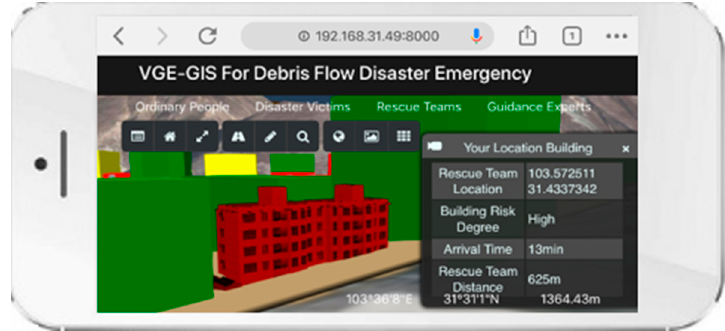
Figure 8. Virtual debris flow disaster environment for disaster victims on mobile terminals.